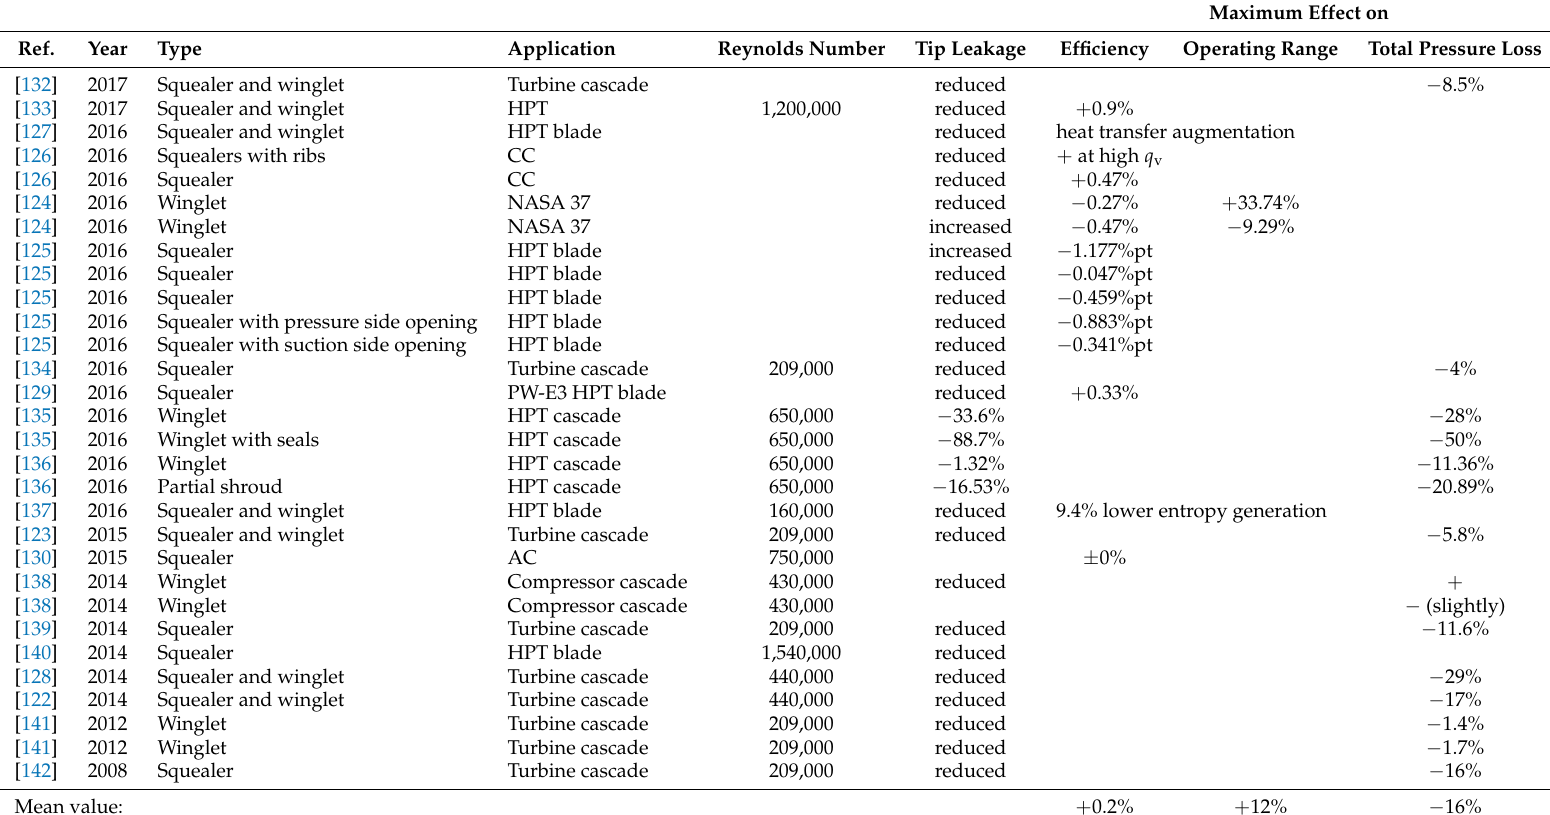
Table 8. Representative summary of squealer and winglet